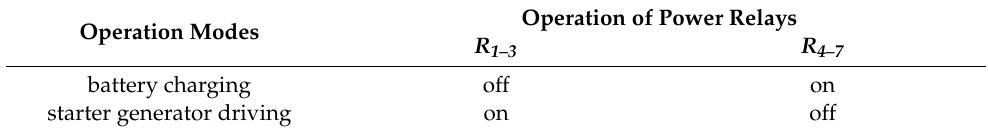
Table 1. Operation modes of the integrated OBC.